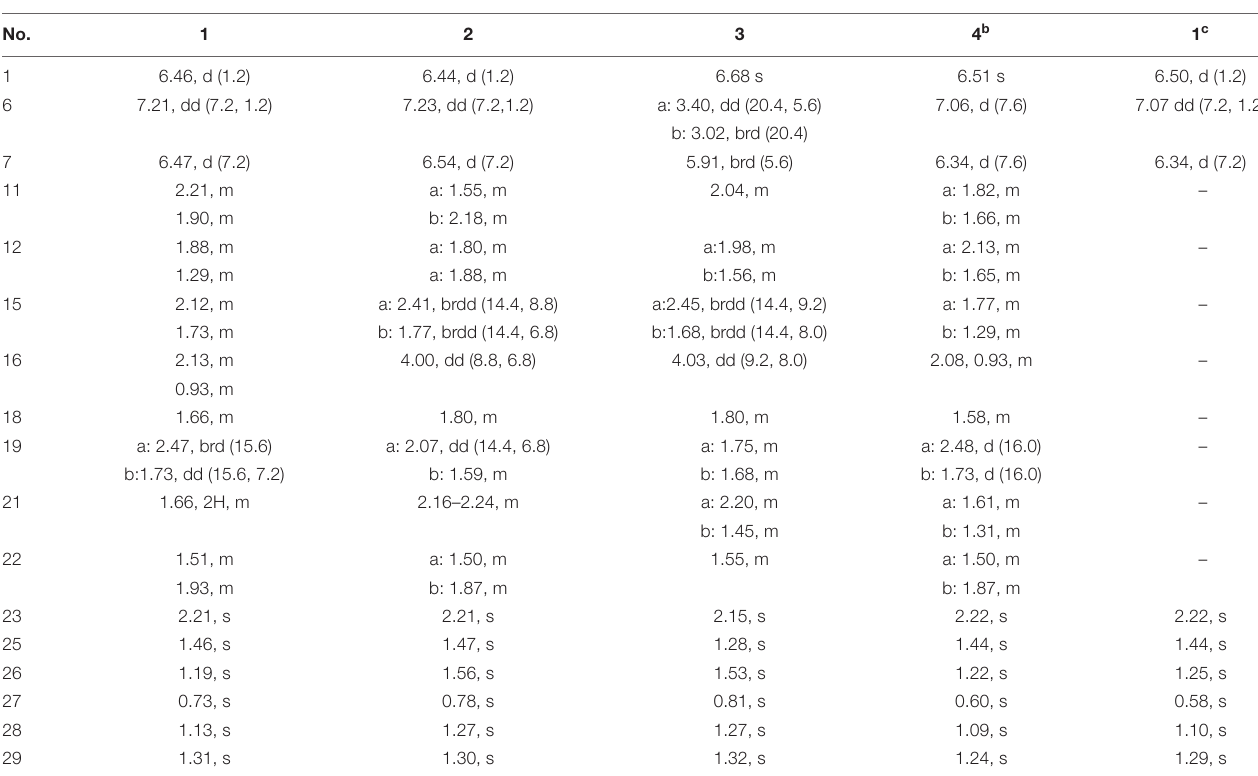
TABLE 1 | 1 H NMR spectroscopic data for compounds 1 – 3 in CD 3 OD and 4 in CDCl 3a .